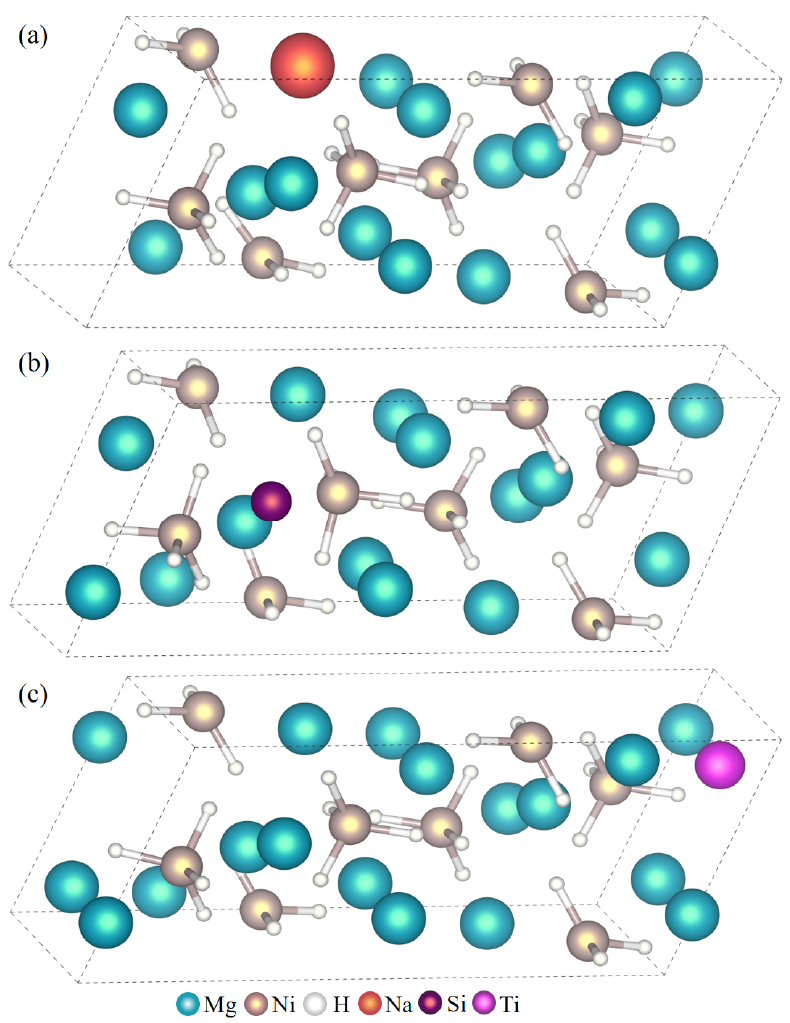
Figure 6. ( a ) stands for the Na doped Mg 2 NiH 4 , ( b )stands for the Si doped Mg 2 NiH 4 , ( c )stands for the Ti doped Mg 2 NiH 4 . The atomic configurations of most thermodynamically stable doped Mg 2 NiH 4 respectively with Na, Si and Ti: Na dopes Mg1 site, Si dopes Mg2 site and Ti dopes Mg3 site.